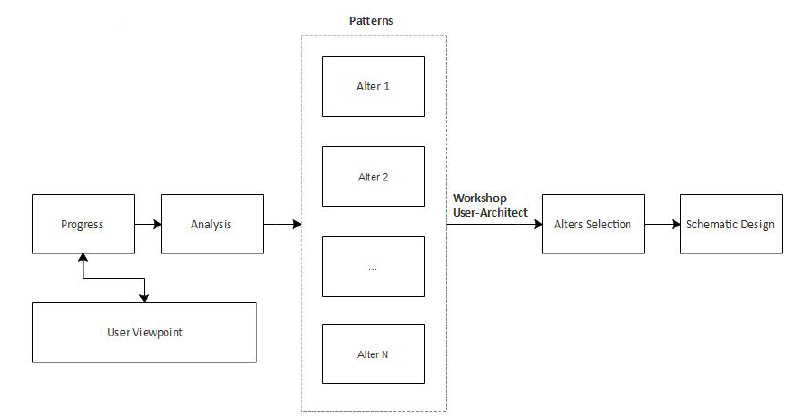
Figure 8. Consultative participation model (source: authors)